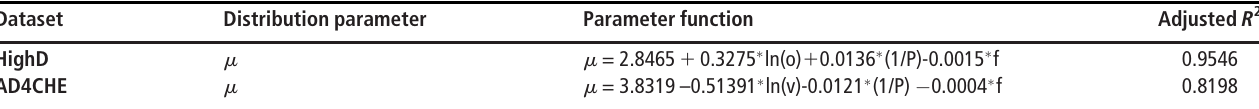
Table 8 Parameter functions of Inverse-Gaussian models